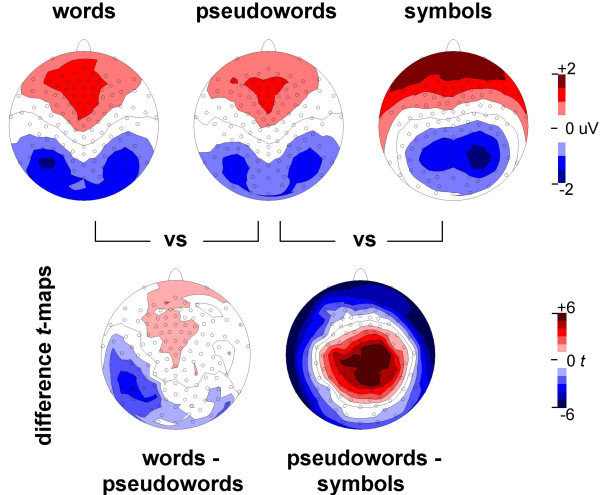
Generalization of reading-related N170 expertise to novel word forms. The pseudoword N170 differs from both the symbol N170 and the word N170, but the two effects show distinct topographies. The pseudoword-symbol effect shows large differences at inferior (surrounding negative difference) and superior (central positive difference) locations. The word-pseudoword effect is most pronounced over left occipito-temporal electrodes. Critical t-values are 2.14 (p<0.05), 2.98 (p<0.01), and 4.14 (p<0.001).